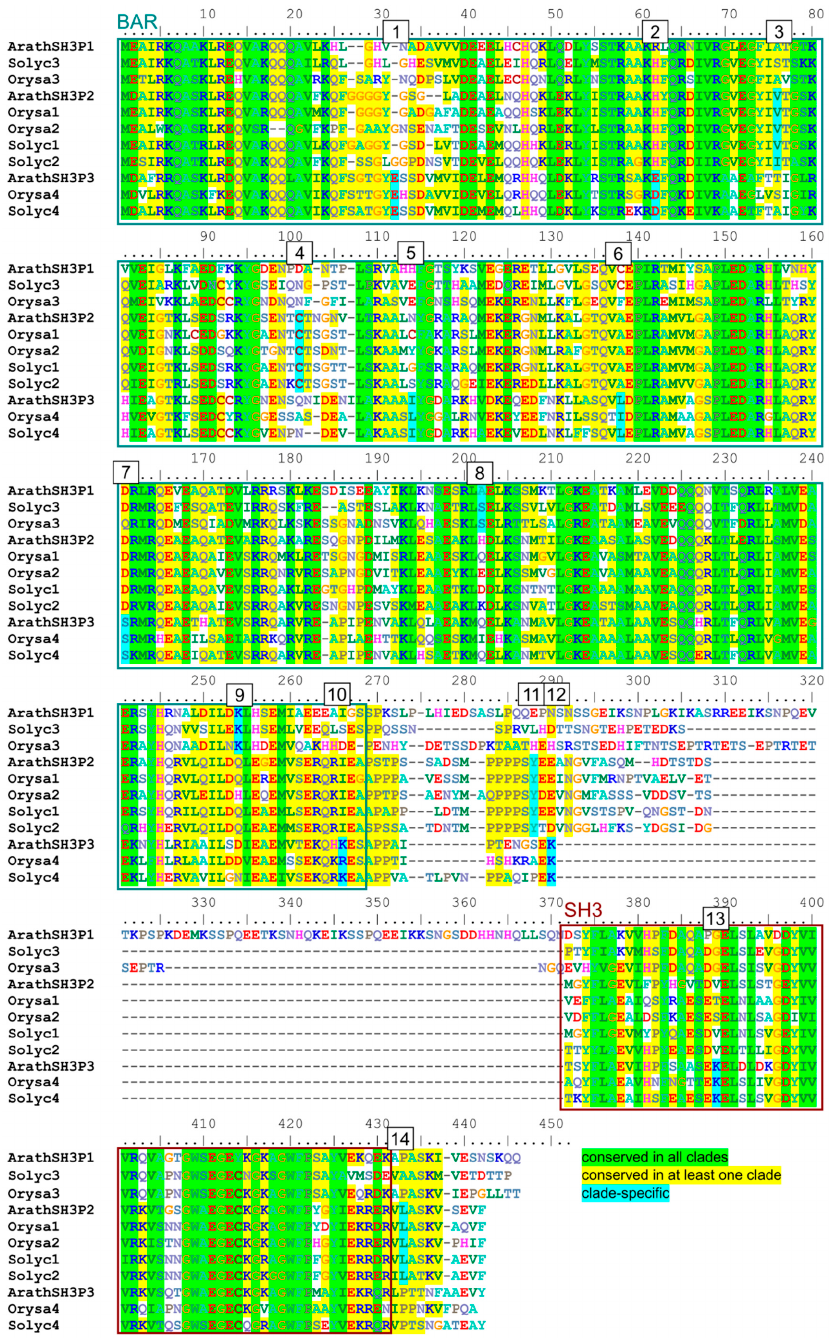
Figure 4. Alignment of representative angiosperm SH3P sequences. Conserved positions, as determined from a larger alignment, including all full-length angiosperm SH3P sequences (see Supplementary Figure S2), are highlighted in colour. Sites with amino acid category conserved across all sequences are shown in green, those with amino acid category shared by all members of at least one clade and present in at least one member of another clade in yellow, and clade-specific positions (i.e., those where amino acid type is shared by all members of one clade but not with other clades) are highlighted in turquoise and numbered. Domain borders are shown based on annotation of the Uniprot record for Arabidopsis SH3Ps. Amino acid categories are defined as follows: Aliphatic (MILV), small hydrophilic (STPAG), aromatic (FYW), cysteine (C), acid and acid amide (NDEQ), basic (HRK). For sequence descriptions, see Supplementary Table